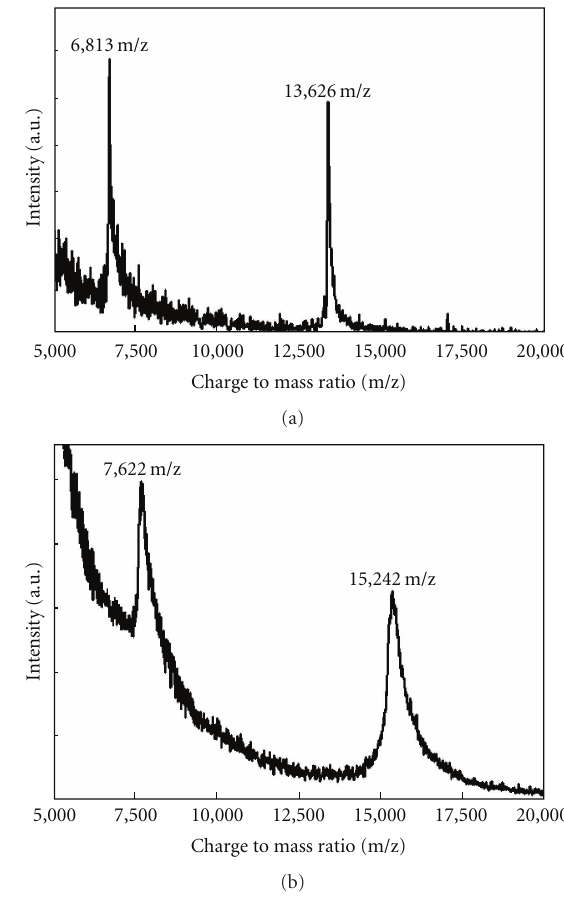
Figure 1: MALDI-TOF analysis of pure oligonucleotide starting material (a) and peptide-oligonucleotide conjugate